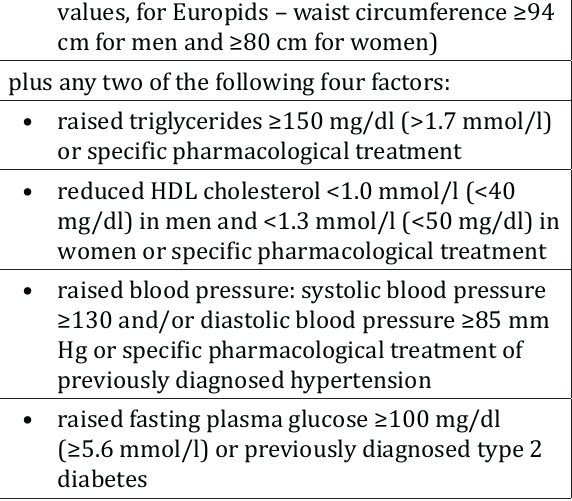
Table 1. The International Diabetes Federation criteria of the Metabolic Syndrome